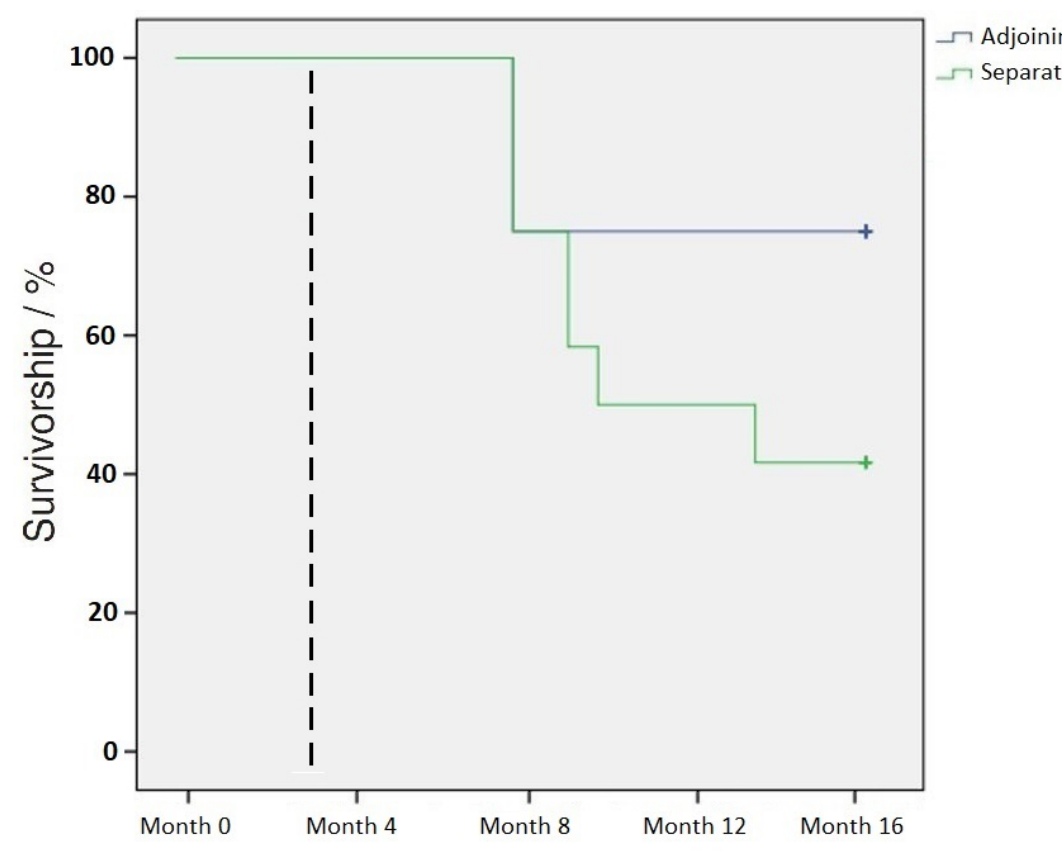
Figure 4. Mean survivorship (%) of adjoining and separate treatments of Platygyra sinensis across 16 months. Dotted line indicates when contact occurred between fragments in the adjoining treatment.